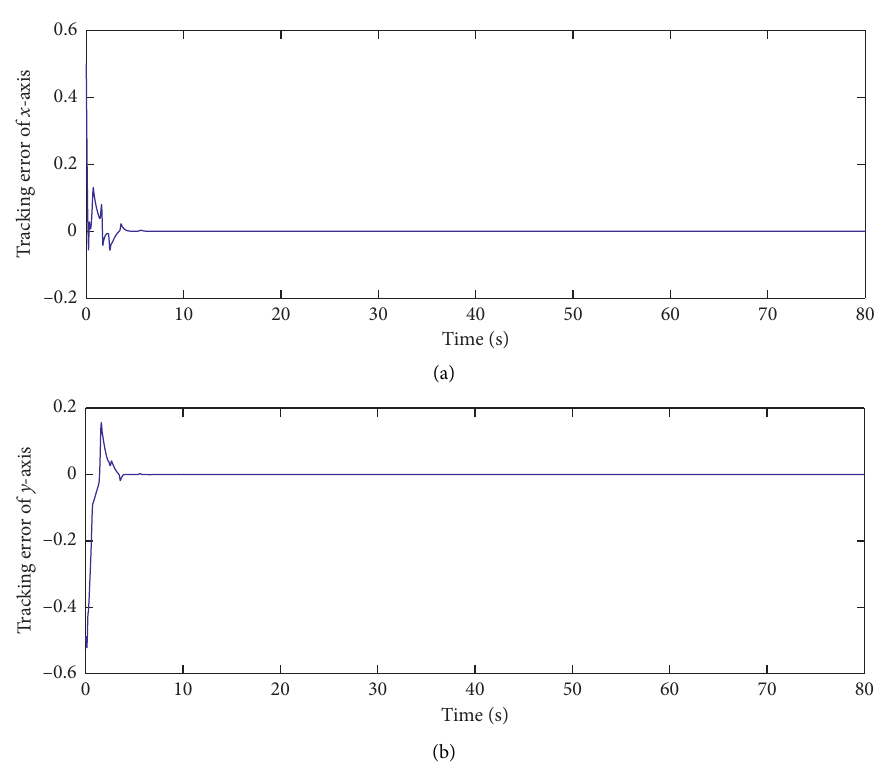
Figure 4: Tracking error using fractional fast TSM